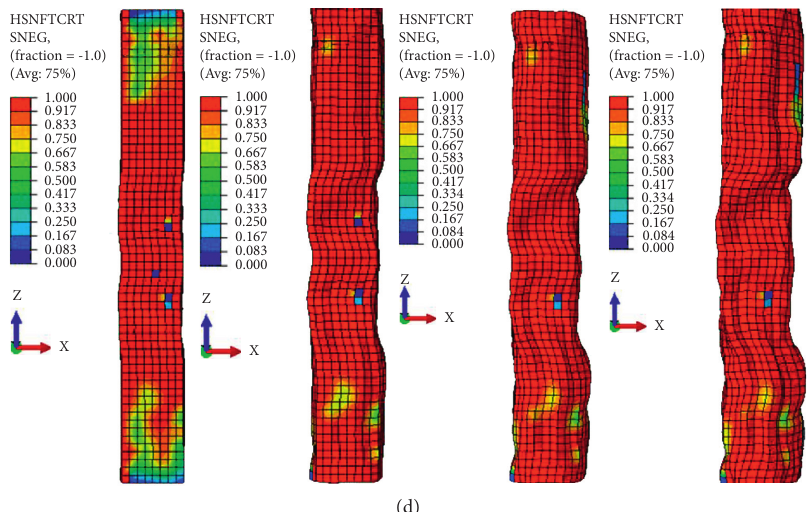
Figure 18: Hashin’s damage criteria of CFRP: (a) fiber tensile rupture, (b) fiber compressive buckling, (c) matrix tensile cracking, and (d) matrix compressive crushing.